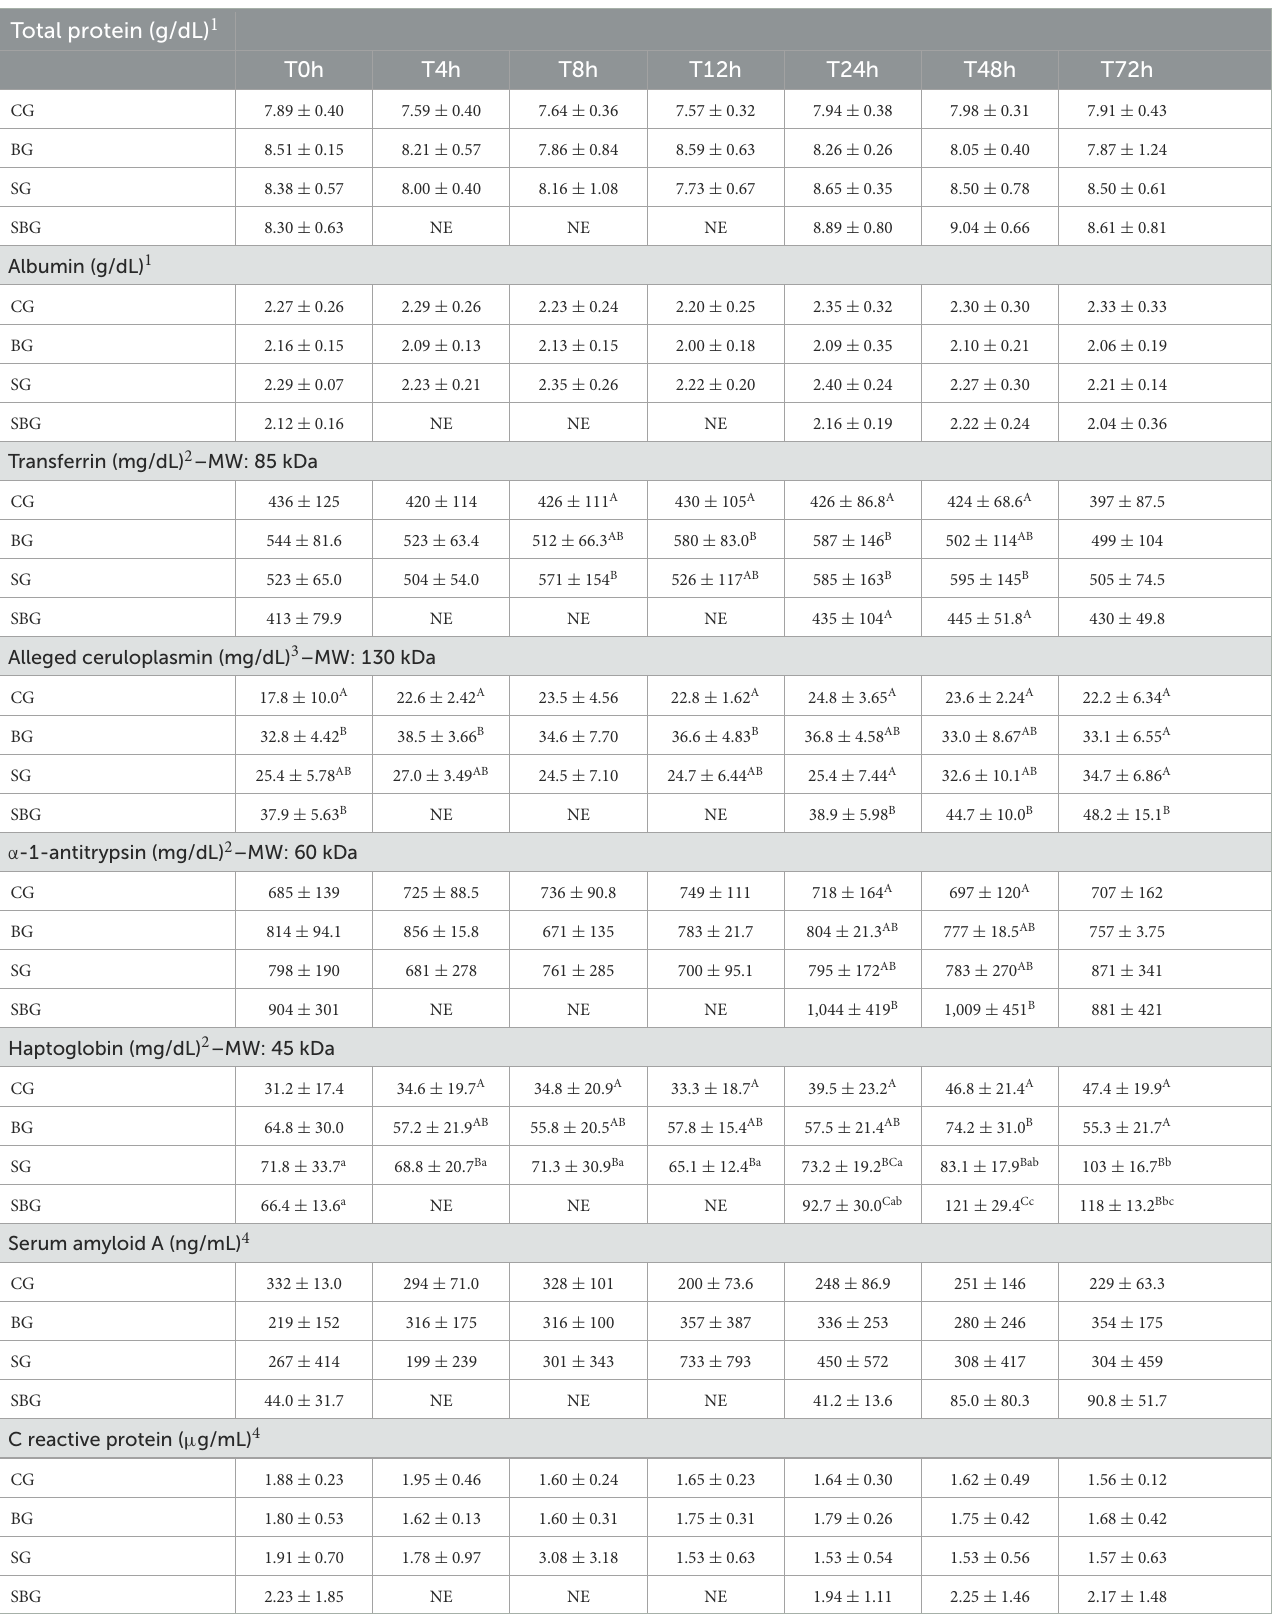
TABLE 3 Mean ± standard deviation of serum concentrations of total protein, albumin, α -1-antitrypsin, C-reactive protein, transferrin, ceruloplasmin, haptoglobin and serum amyloid A of horses in each experimental group (CG, control; BG, buffer; SG, starch; SBG, starch/buffer); during the seven evaluated moments (T0h, T4h, T8h, T12h, T24h, T48h, and